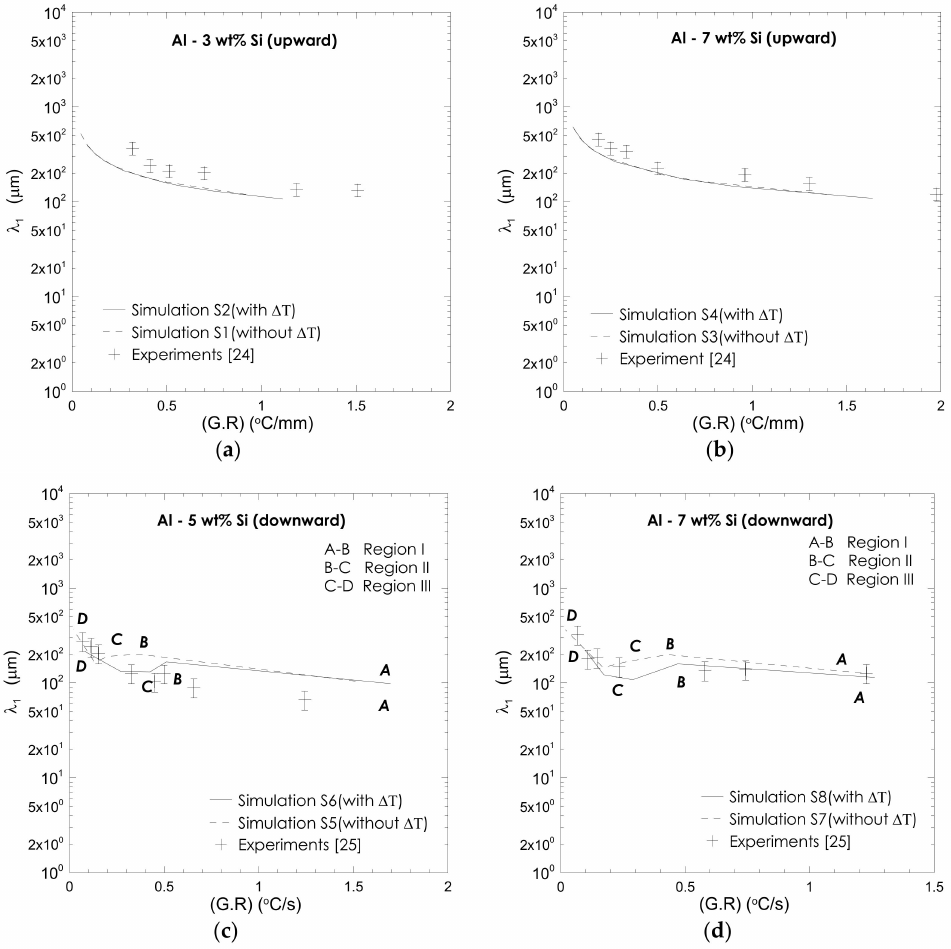
Figure 20. Effect of the undercooling on primary arm spacing during solidification. ( a ) 3% upward compared to experiments [18]; ( b ) 7% upward compared to experiments [18]; ( c ) 5% downward compared to experiments [30]; ( d ) 7% downward compared to experiments